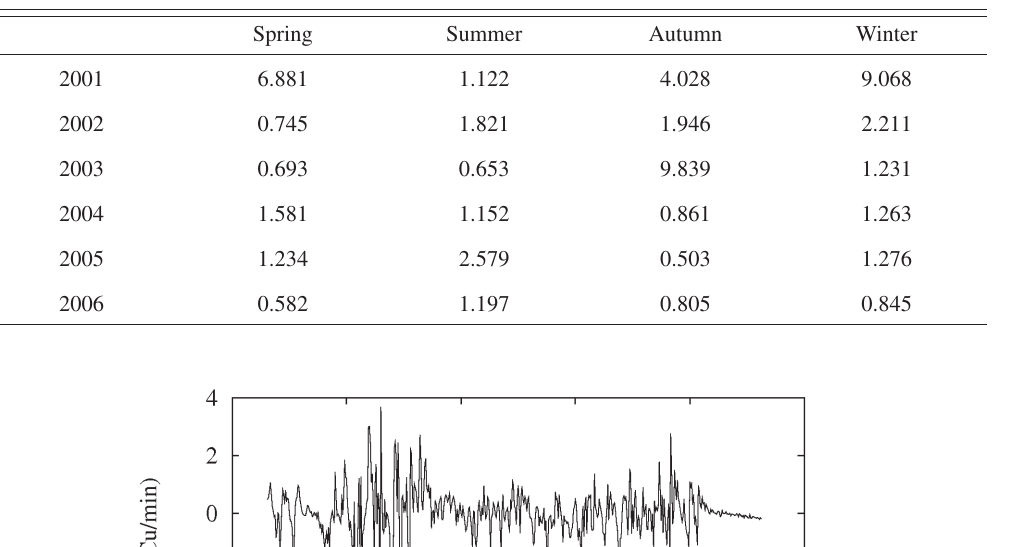
Table II. Maximum seasonal RoTEC values at Brussels from January 2001 to December 2006 (expressed in TECU/min).